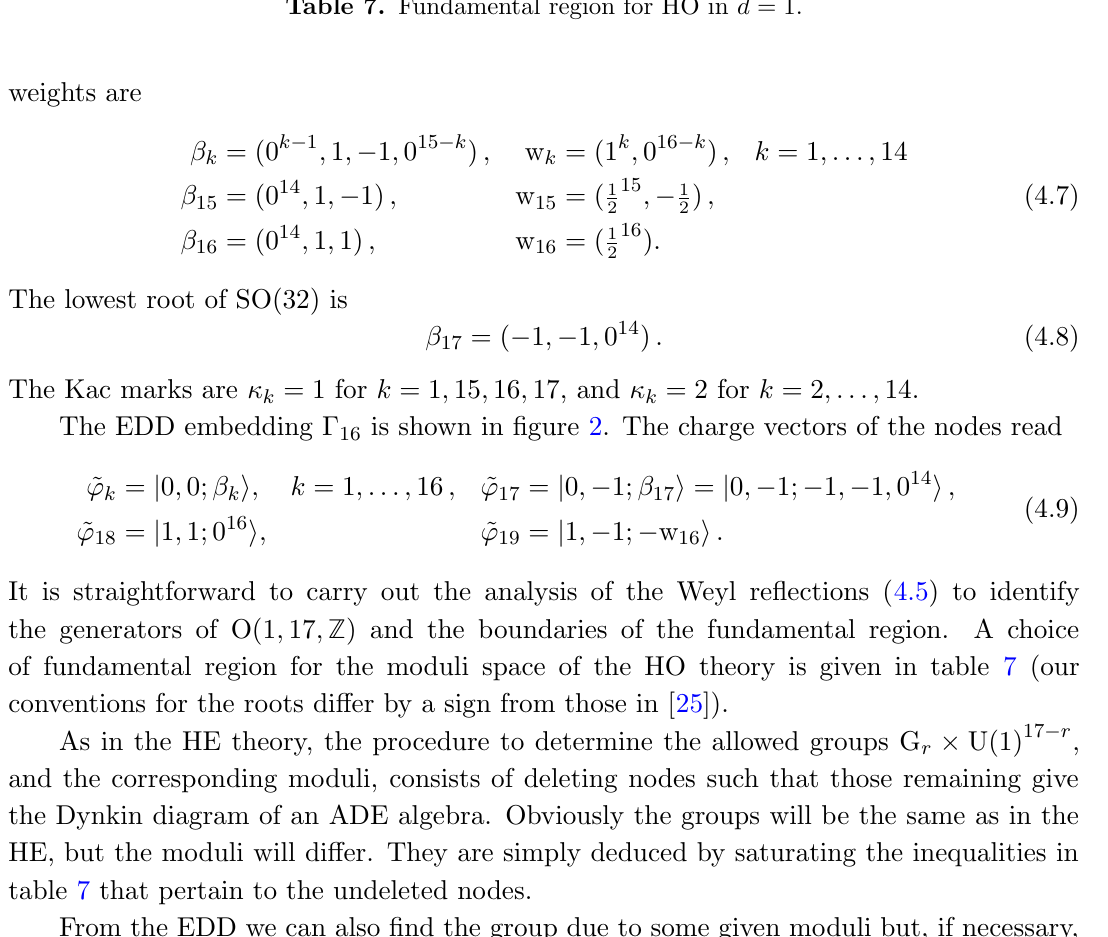
Table 7. Fundamental region for HO in d =